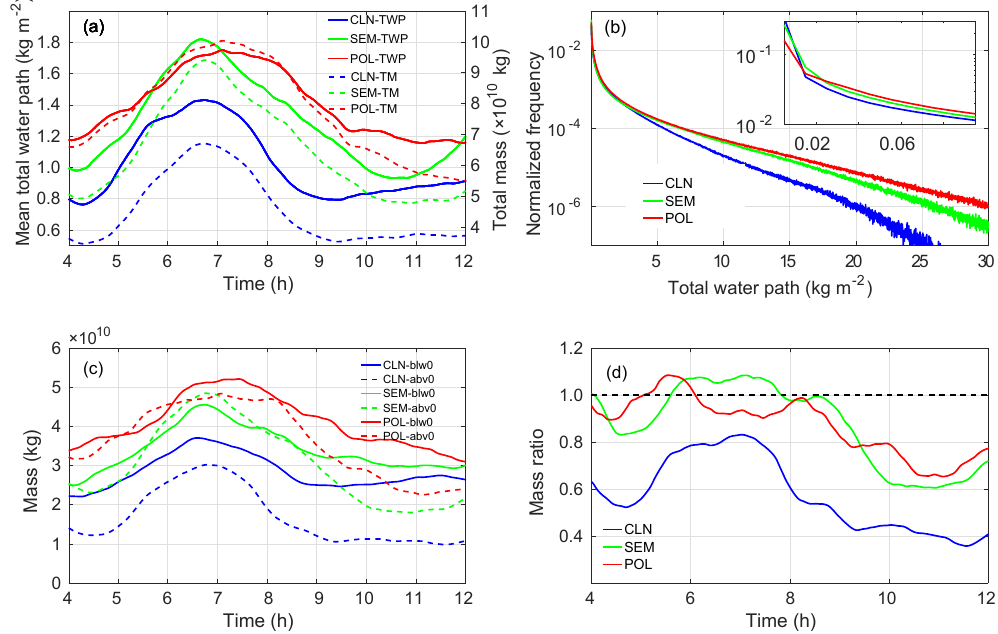
Figure 4. (a) Time series of the mean total water path (TWP; kgm − 2 ) over the cloudy area (solid curves) and the total cloud mass (kg, dashed curves). (b) Normalized occurrence frequency distribution of TWP over the domain during 4 to 12h of the simulation. Time series of (c) total cloud mass above (dashed curves) and below (solid curves) the ZTL and (d) the mass ratios for clean (blue curves), semi-polluted (green curves), and polluted (red curves)